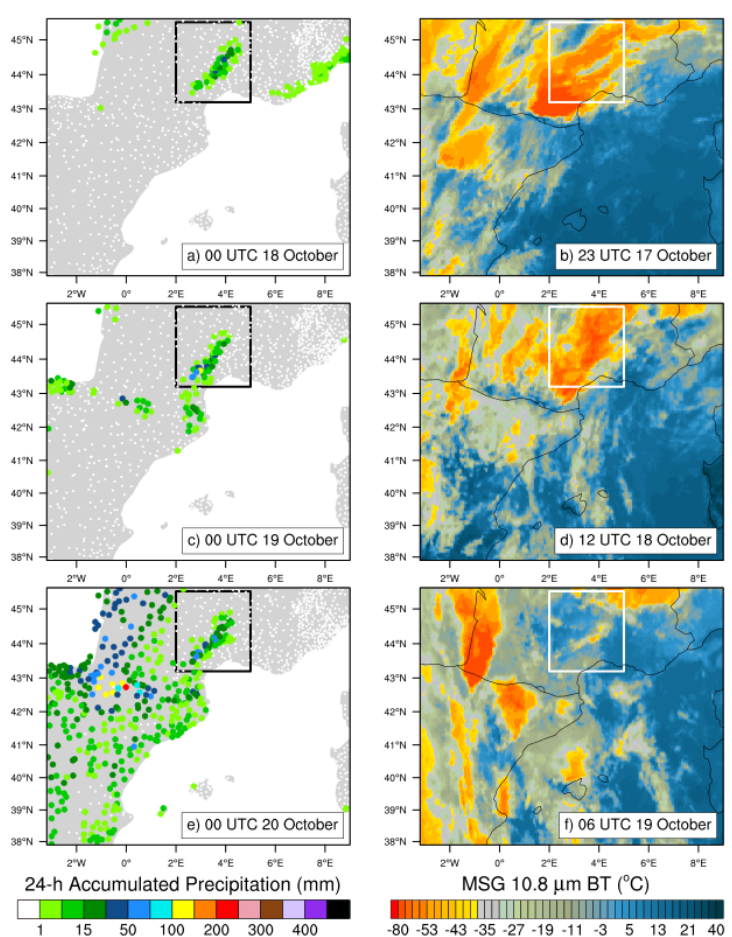
Figure 2. Left column: 24h rainfall amounts (from 00:00UTC) derived from rain gauge measurements on (a) 17 October, (c) 18 October and (e) 19 October 2012. The thick black line delineates the CV area (2–5 ◦ E, 43.2–45.5 ◦ N). Right column: brightness temperature at 10.8µm derived from SEVIRI at (b) 23:00UTC on 17 October, (d) 12:00UTC on 18 October and (f) 06:00UTC of 19 October 2012. The SEVIRI images are shown for the time when BT is smallest over the CV area. The white line delineates the CV